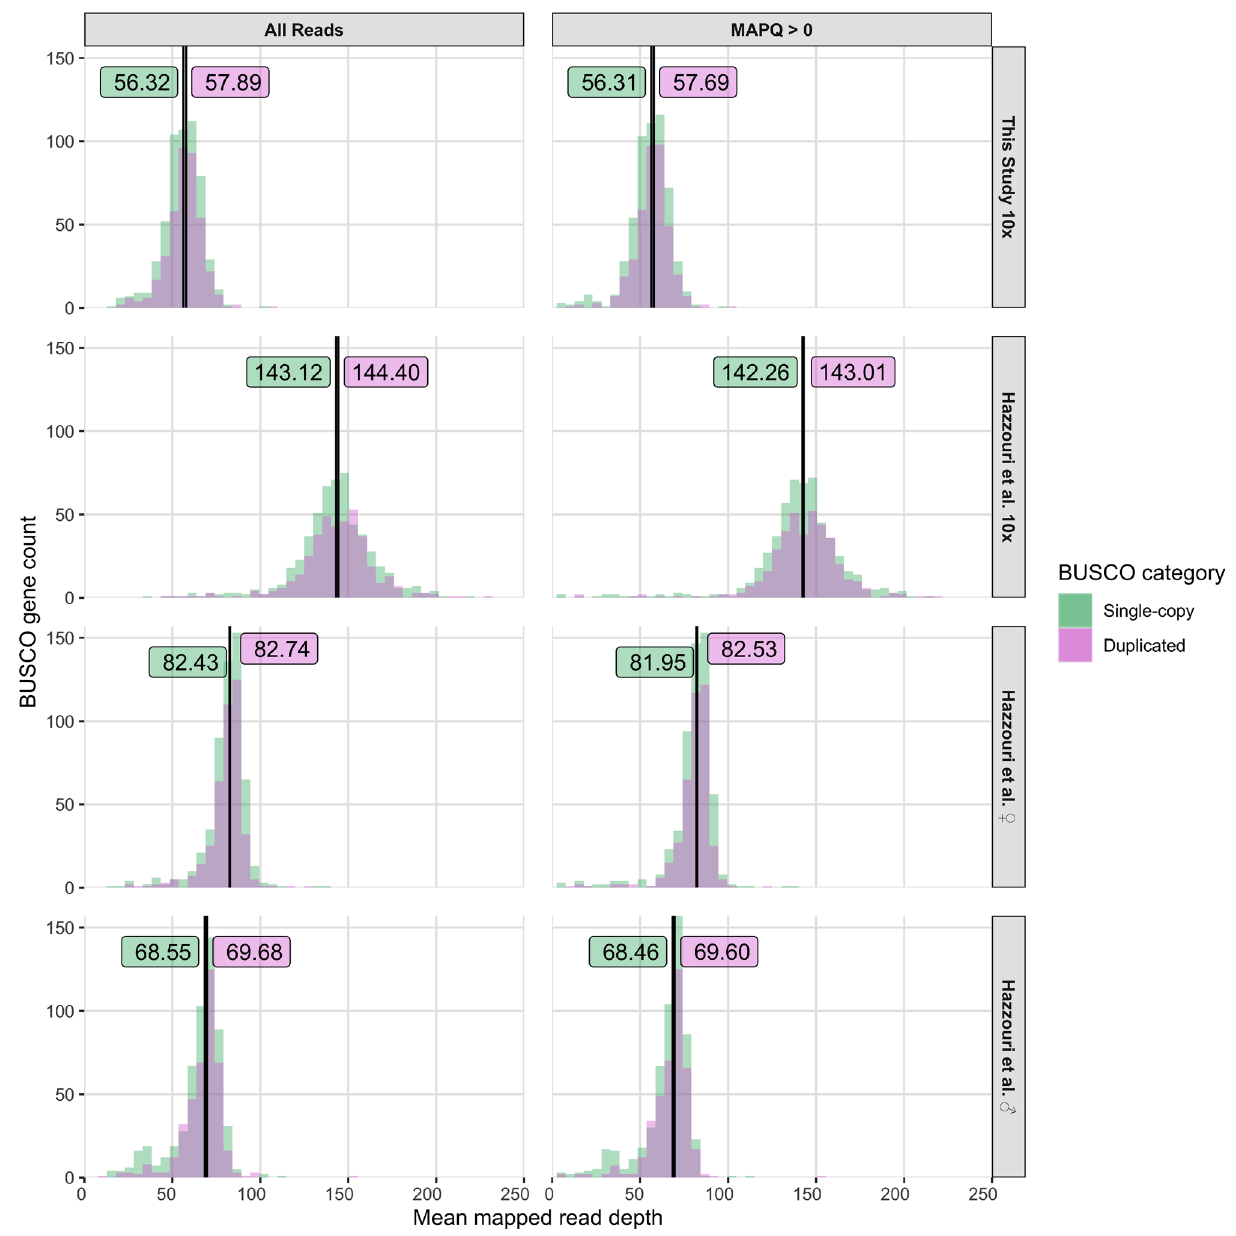
Figure 3. Mapped read depth of BUSCO genes in the RPW pseudo-haplotype1 assembly. BUSCO genes were categorized as single-copy or duplicated based on their status in the M_pseudochr assembly from Hazzouri et al. 18 . The four DNA-seq datasets analyzed are (from top to bottom): 10x Genomics library from this study (SRX7520800), 10x Genomics library from Hazzouri et al. 18 (SRX5416727), female RPW Illumina PE library from Hazzouri et al. 18 (SRX5416728), and male RPW Illumina PE library from Hazzouri et al. 18 (SRX5416729). Depth estimates based on all mapped read and high quality mapped reads (MAPQ > 0) are shown in the left and right columns, respectively. The median values for each depth distribution are given as labeled vertical lines.